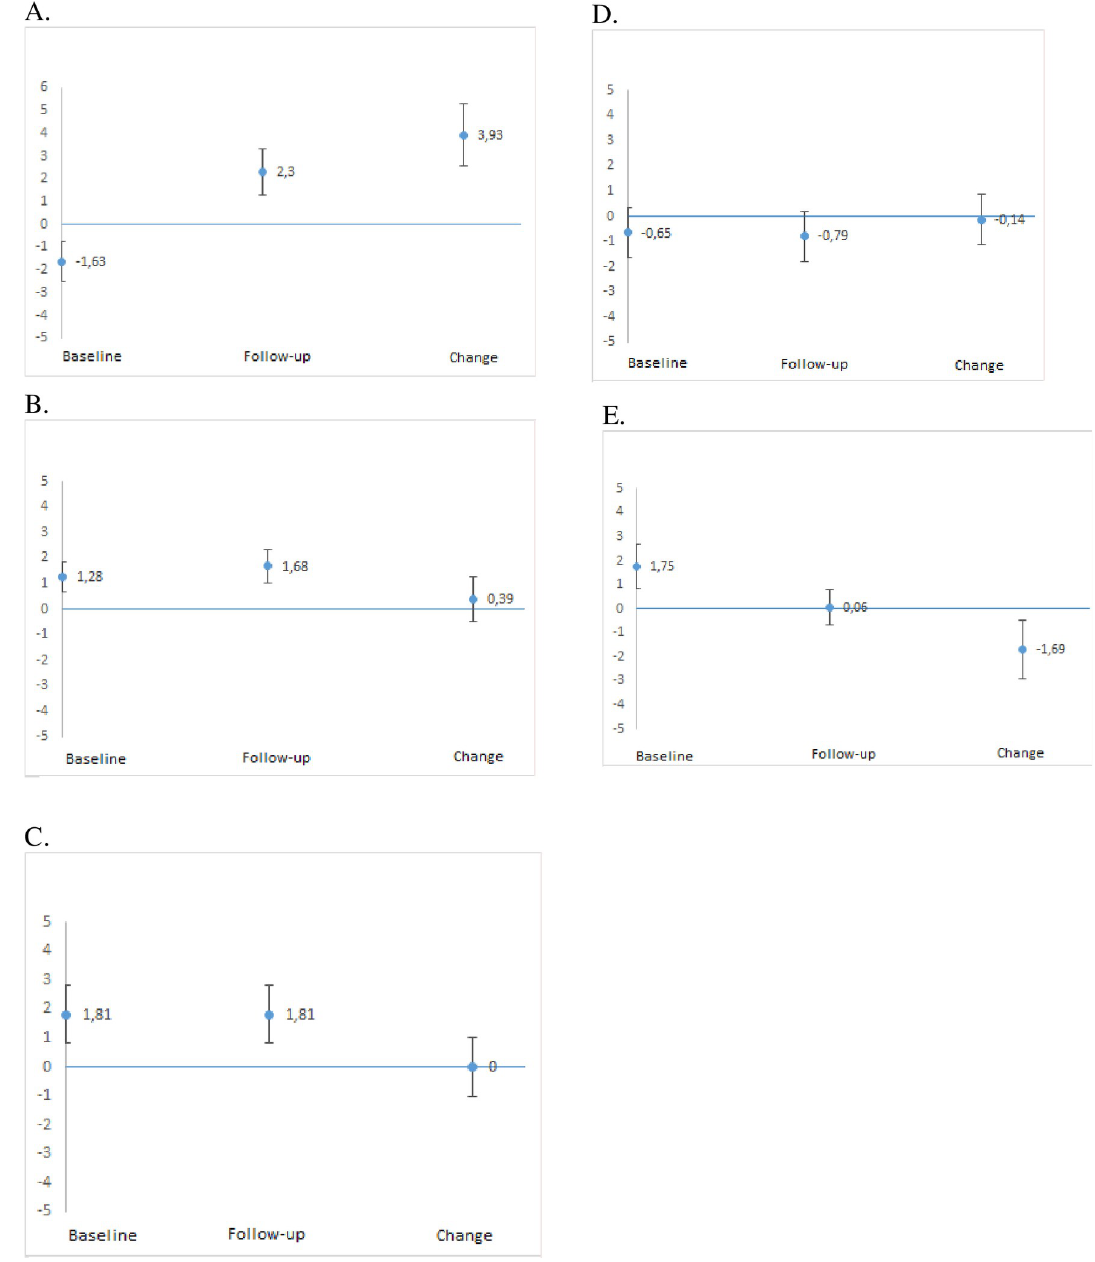
Fig 1. Individual person-level raw total scores translated to linear logit scale location values (y-axis) for baseline, follow-up, and change in locations (follow-up location − baseline location) (x-axis) together with 95% confidence intervals (CIs). Panel A illustrates significant improvement (95% CI for change does not overlap zero) in Communication and Trust (CaT) score for Case 147. Panel B illustrates non-significant improvement in Next of Kin Participation in Care (NoK-PiC) score for Case 25. Panel C illustrates no change in CaT score for Case 186. Panel D illustrates non-significant worsening in Collaboration in Care (CiC) score for Case 13. Panel E illustrates significant worsening (95% CI for change does not overlap zero) in CiC score for Case 179.